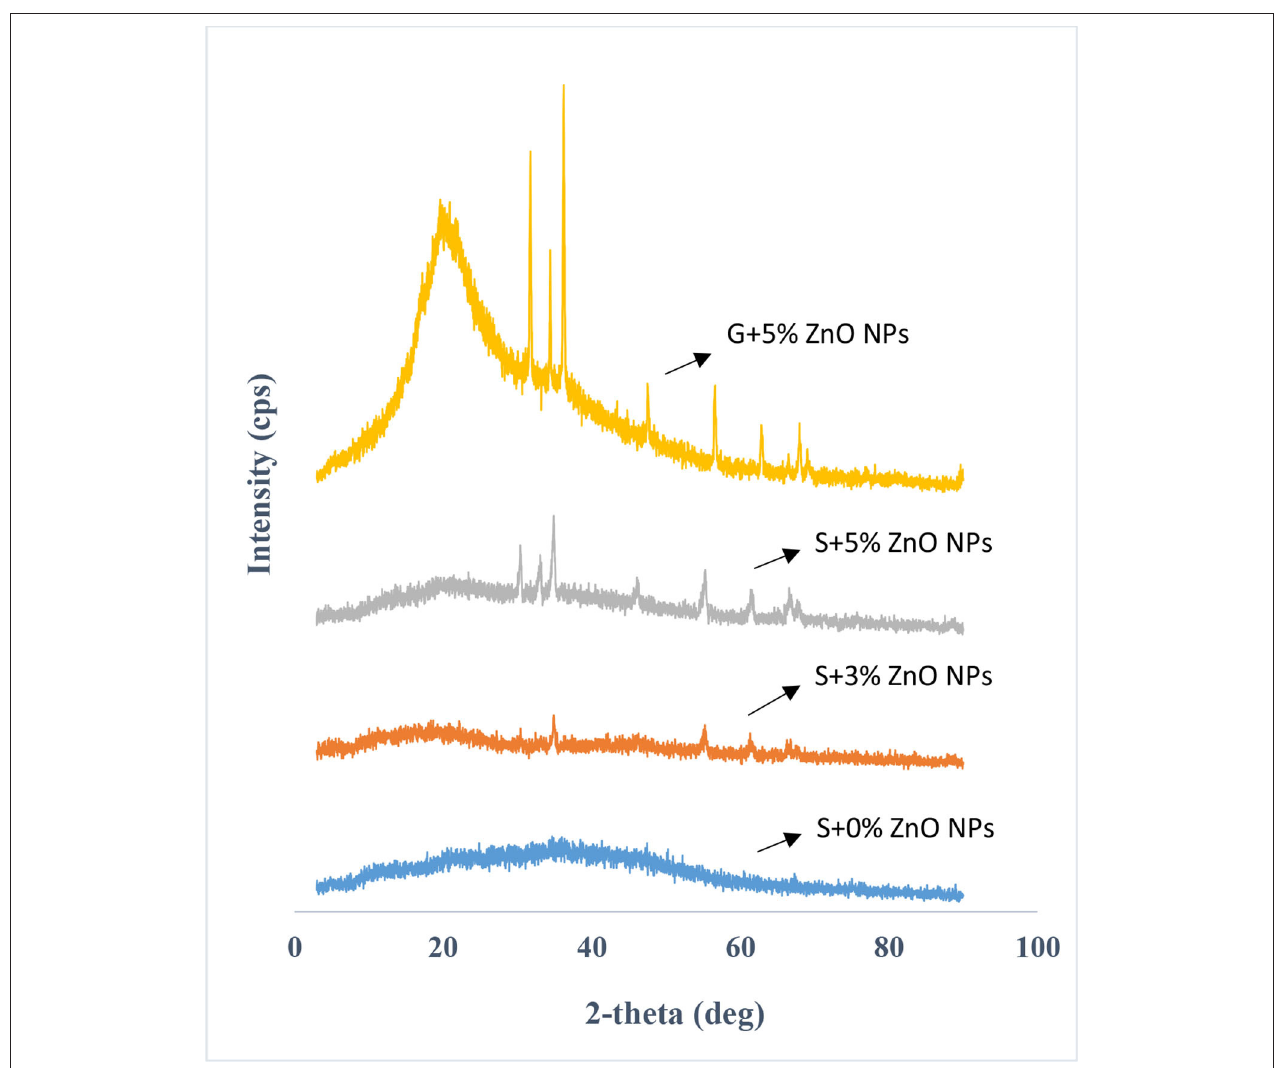
FIGURE 3 | X-ray diffraction (XRD) of bionanocomposite